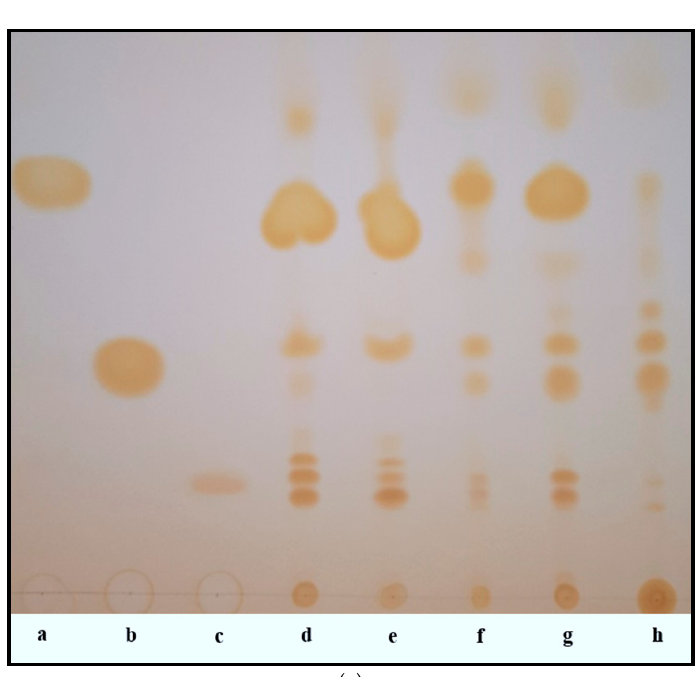
( b ) Figure 5. ( a ) Separation of neutral lipids fractions, extracted by the five strains dry biomass, culti- vated in second CW through thin layer chromatography. a: triacylglycerol standard; b: free fatty acids standard; c: cholesterol standard; d: C. curvatus ATCC 20509/74 h; e: C. curvatus NRRL Y- 1511/218 h; f: P. laurentii NRRL Y-2536/119 h; g: P. laurentii NRRL Y-3594/101 h; h: D . hansenii ACA- DC 5079/170 h of cultivation. ( b ) Separation of neutral lipids fractions, extracted at different time spots during the fed-batch cultivation of C. curvatus ATCC 20509, through thin layer chromatog- raphy. a: cholesterol standard; b: free fatty acids standard; c: triacylglycerol standard; d: 70 h; e: 154 h; f: 178 h; g: 257 h; h: 312 h of cultivation.